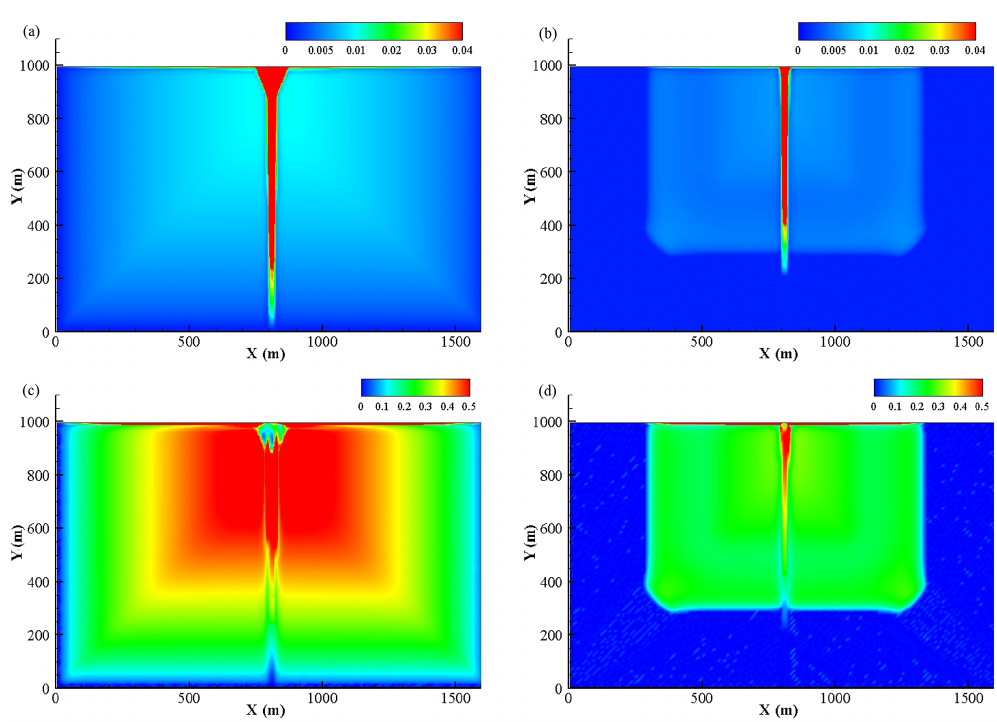
Figure 14. Water depth (m) and velocity distribution (ms − 1 ) at 90min (a, c) and 120min (b, d) .